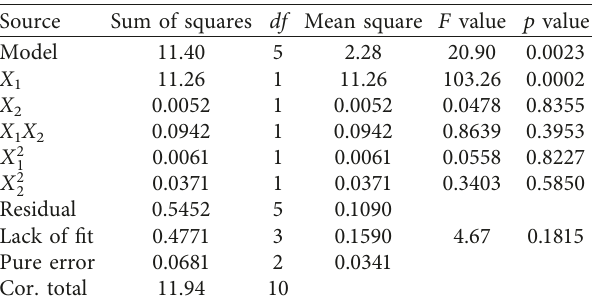
2 O concentration